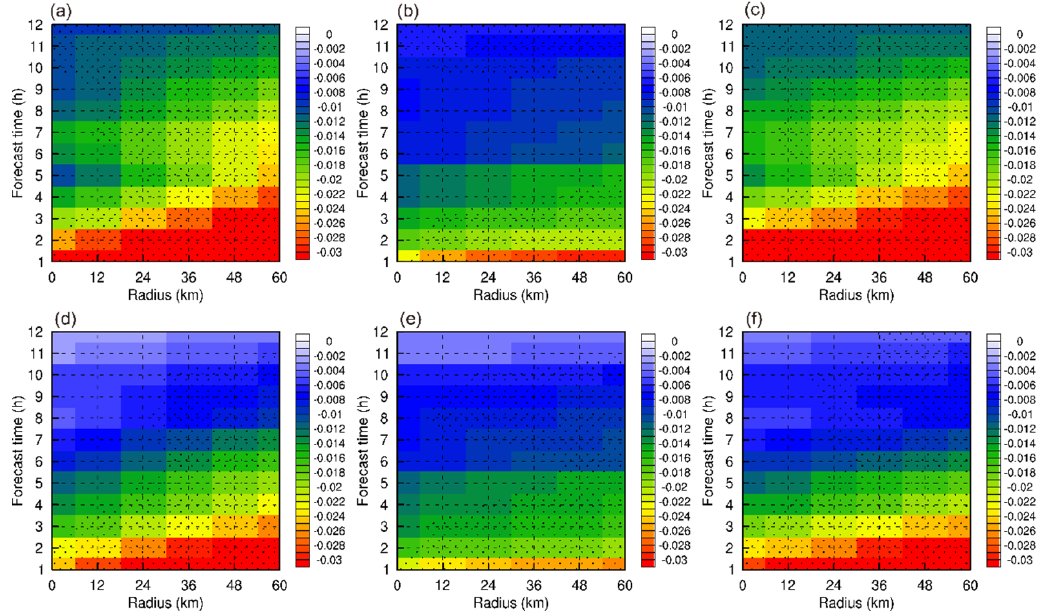
Figure 9. Di ff erences between the fractional Brier score (FBS) of ( a , d ) NEP and GP, ( b , e ) EAS_NEP and GP, and ( c , f ) OBJ_NEP and GP with precipitation thresholds of (top) 1 mm / h and (bottom) 5 mm / h under SF. The dotted areas show the 90% bootstrap confidence